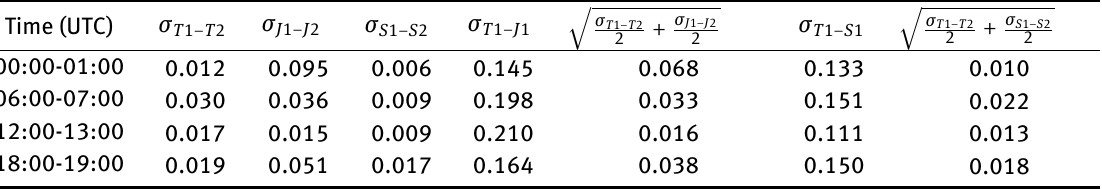
Table 2: Standard deviations in millimeters of receiver phase biases for various receiver combinations Time (UTC)